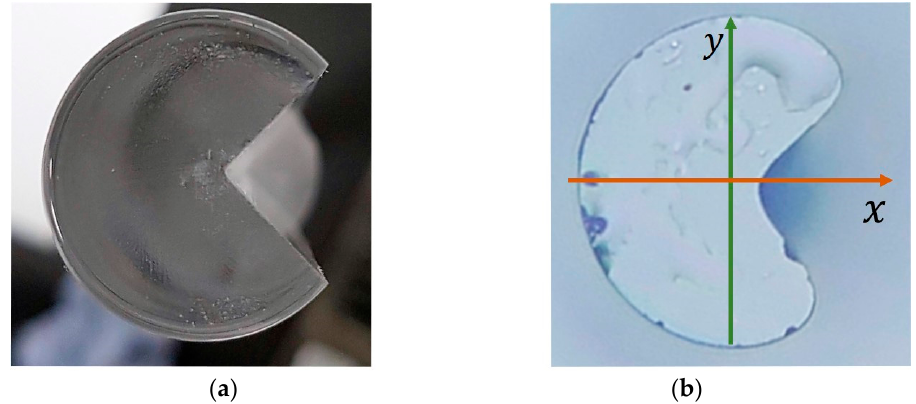
Figure 4. ( a ) Preform of standard single-mode fiber with a quadrant cut out. ( b ) Fiber-end image of the C-shaped fiber.